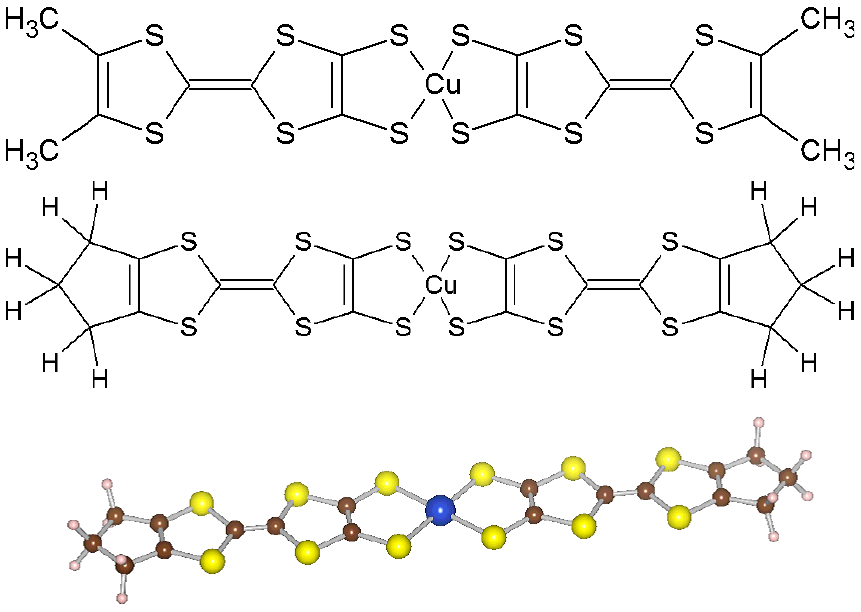
Figure 1. Chemical formulae of Cu(dmdt) dimensional views of a Cu(tmdt) and